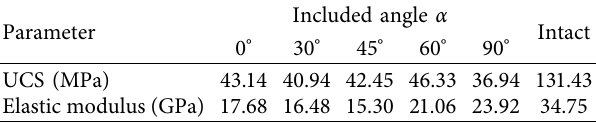
Table 1: UCS and elastic modulus of specimens.